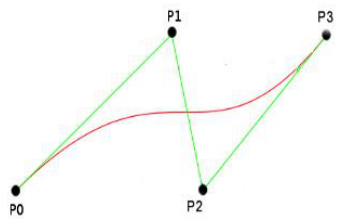
Figure 2. Cubic Bezier curve (red), control polygon (green).